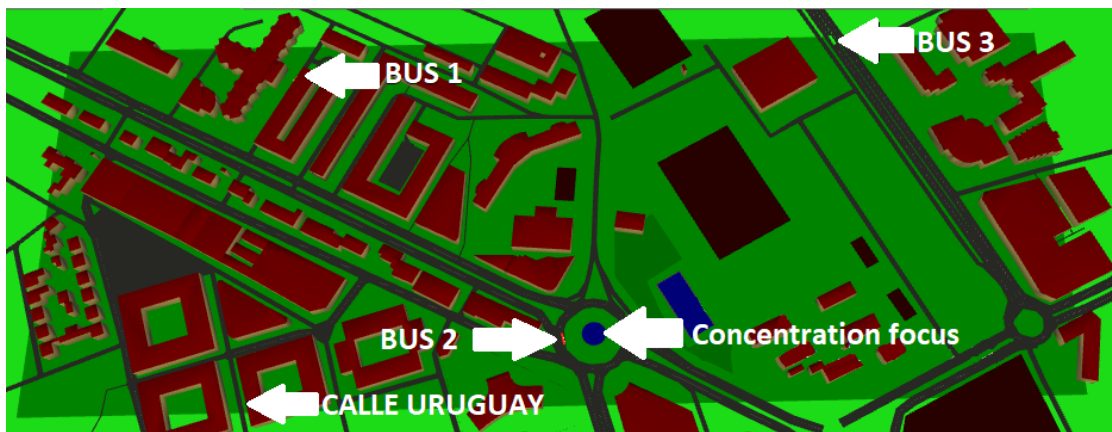
Figure 8. Virtual world used for evaluation of CityOnStats. The overlaid arrows indicate a roundabout that was used as the focus of pollution, three circulating buses in guided mode, and the location of Calle Uruguay, a street used for one of the tests challenges.